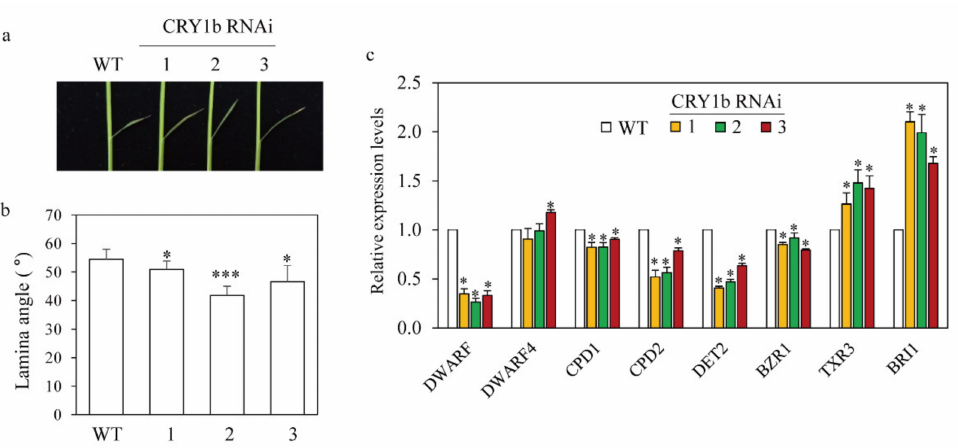
Figure 5. Lamina joint angles and transcript induction profiles of brassinosteroid (BR)-related genes in WT and CRY1b RNAi (1–3) rice plants. ( a ) Photograph of representative lamina joints in plants grown for 10 days in soil pots. ( b ) Lamina joint angles in WT and transgenic rice seedlings. ( c ) Quantitative real-time PCR analysis of the expression of various BR-related genes in WT and CRY1b RNAi plants. GenBank accession numbers are Os03g0602300 ( DWARF ), Os03g12660 ( DWARF4 ), Os11g0143200 ( CPD1 ), Os12g0139300 ( CPD2 ), Os01g0851600 ( DET2 ), Os07g39220 ( BZR1 ), AP005859 ( TXR3 ), AK101085 ( BRI1 ), and Os03g13170 ( UBQ 5). Lines 1–3 are RNAi rice plants with downregulated CRY1b genes. * p < 0.05, *** p < 0.001, Tukey’s HSD post-hoc